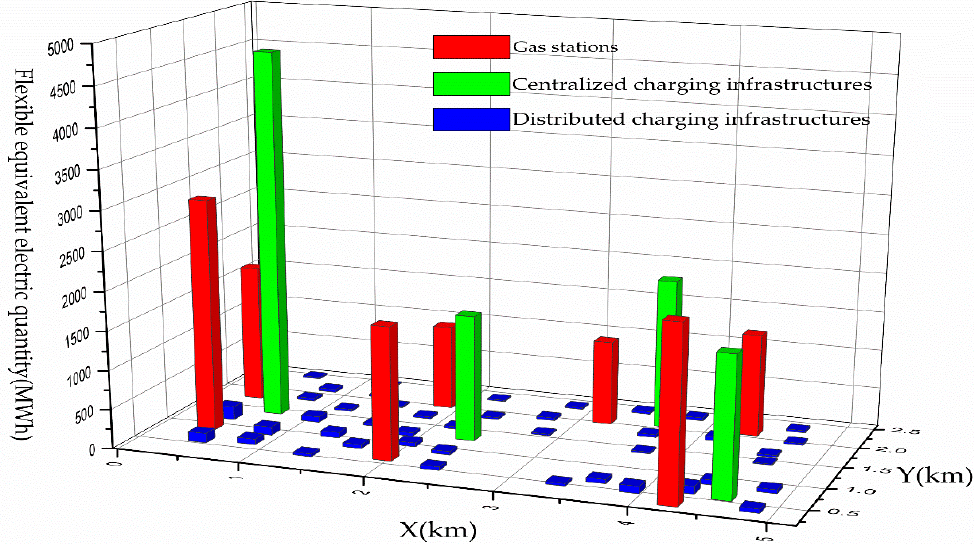
Figure 8. The geographical locations of FEEQ.